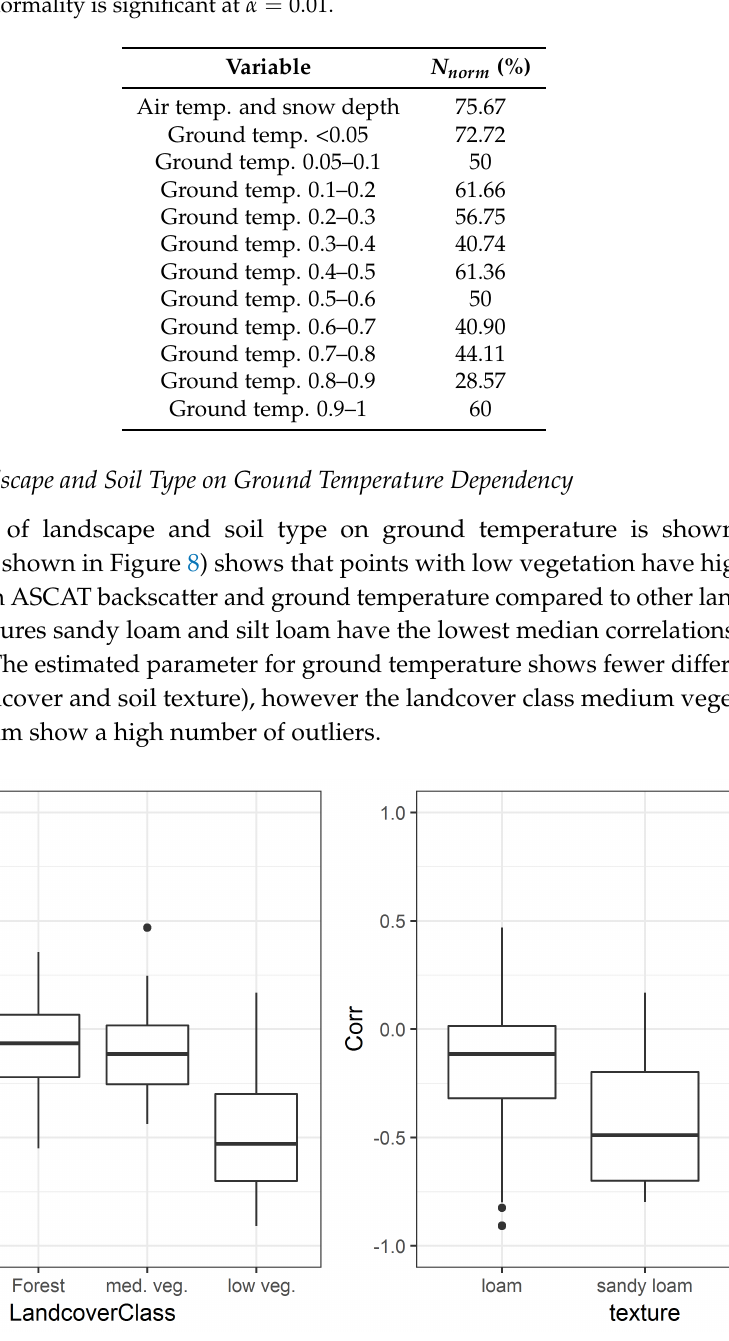
Figure 8. Correlation of backscatter and ground temperatures (for depths from near–ground surface to 20 cm) for different landcover classes and soil